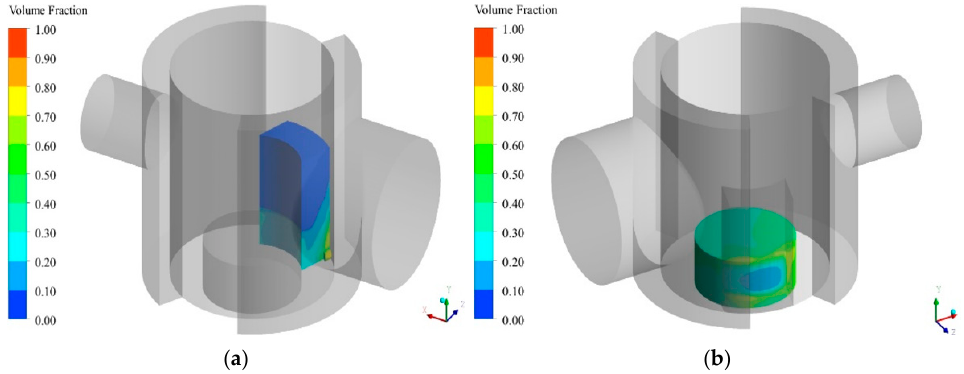
Figure 9. The simulated vapor distribution. ( a ) Valve port vapor volume fractions (VVF); ( b ) pump chamber VVF.